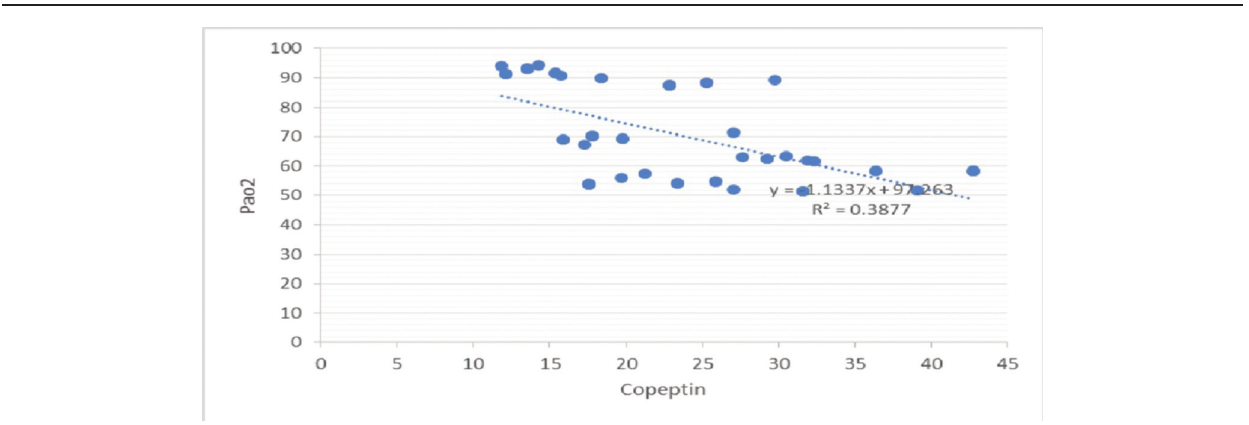
Correlation between copeptin and PaO 2 . PaO 2 , partial pressure of oxygen in arterial